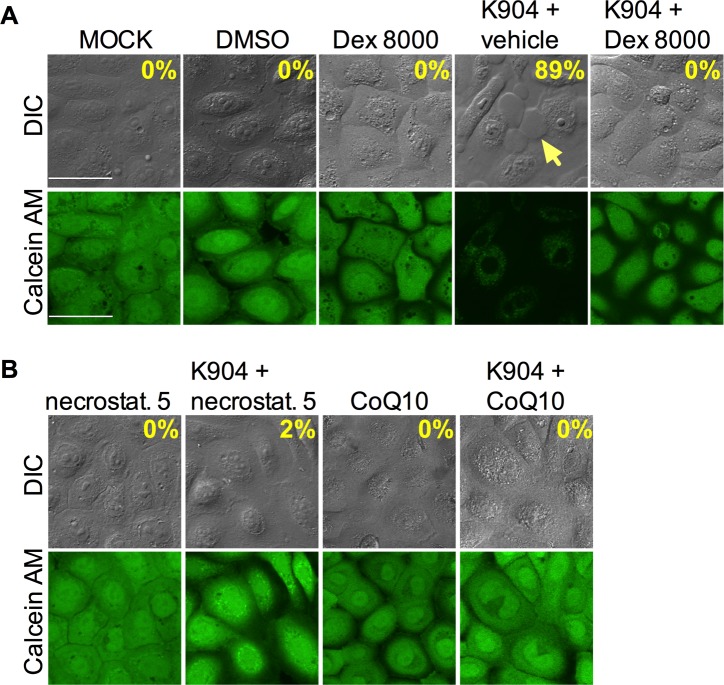
ShlA induces bleb formation and cytotoxicity via pore formation and subsequent necroptosis.Confocal micrographs HCLE cells imaged with differential interference contrast (DIC) and calcein AM viability stain after exposure to bacteria for 2 h at MOI = 50. Yellow arrows indicate blebs extending from corneal cells. HCLE cells were exposed to S. marcescens K904 (MOI = 50 for 2 h) with either (A) dextran sulfate 8000 (30 mM, occludes pores caused by pore-forming toxins), (B) necrostatin 5 (100 μM, an inhibitor of necroptosis), or coenzyme Q10 (CoQ10, 0.1 μM, an antioxidant,) or an equal volume of vehicle DMSO incubated with cells for 1 h prior to challenge.